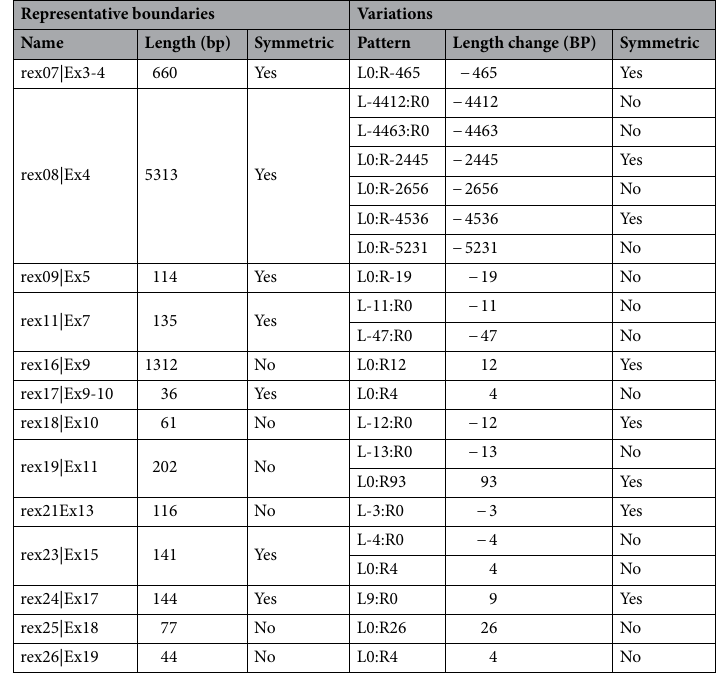
Table 2. Variations of exon boundaries. Patterns of variations are written as “L value 1:R value 2”, where “L” refers to the 5 ′ -end and “R” indicates changes at the 3 ′ -end. A positive value indicates exon extension, and a negative one indicates exon truncation. For example, L-4412:R0 indicates that the 5 ′ -end is truncated by 4412 bp and the 3 ′ -end is